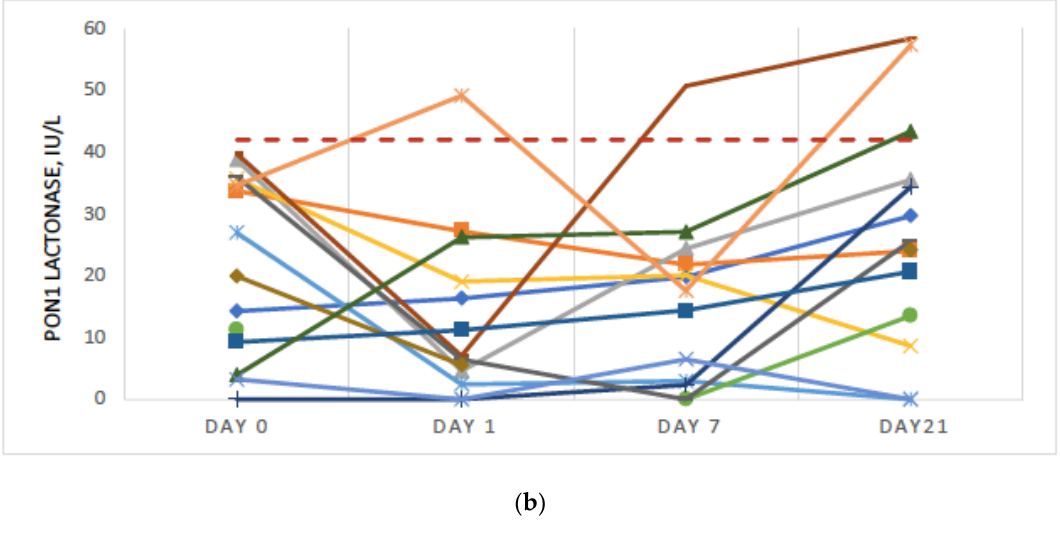
Figure 2. ( a ) Paraoxonase 1 ( PON1) arylesterase activity (IU/L) for individual patients. For comparison, the control group average is shown as a horizontal dotted line; ( b ) PON1 Lactonase Activity (IU/L) for individual patients. For comparison, the control group average is shown as horizontal dotted line.